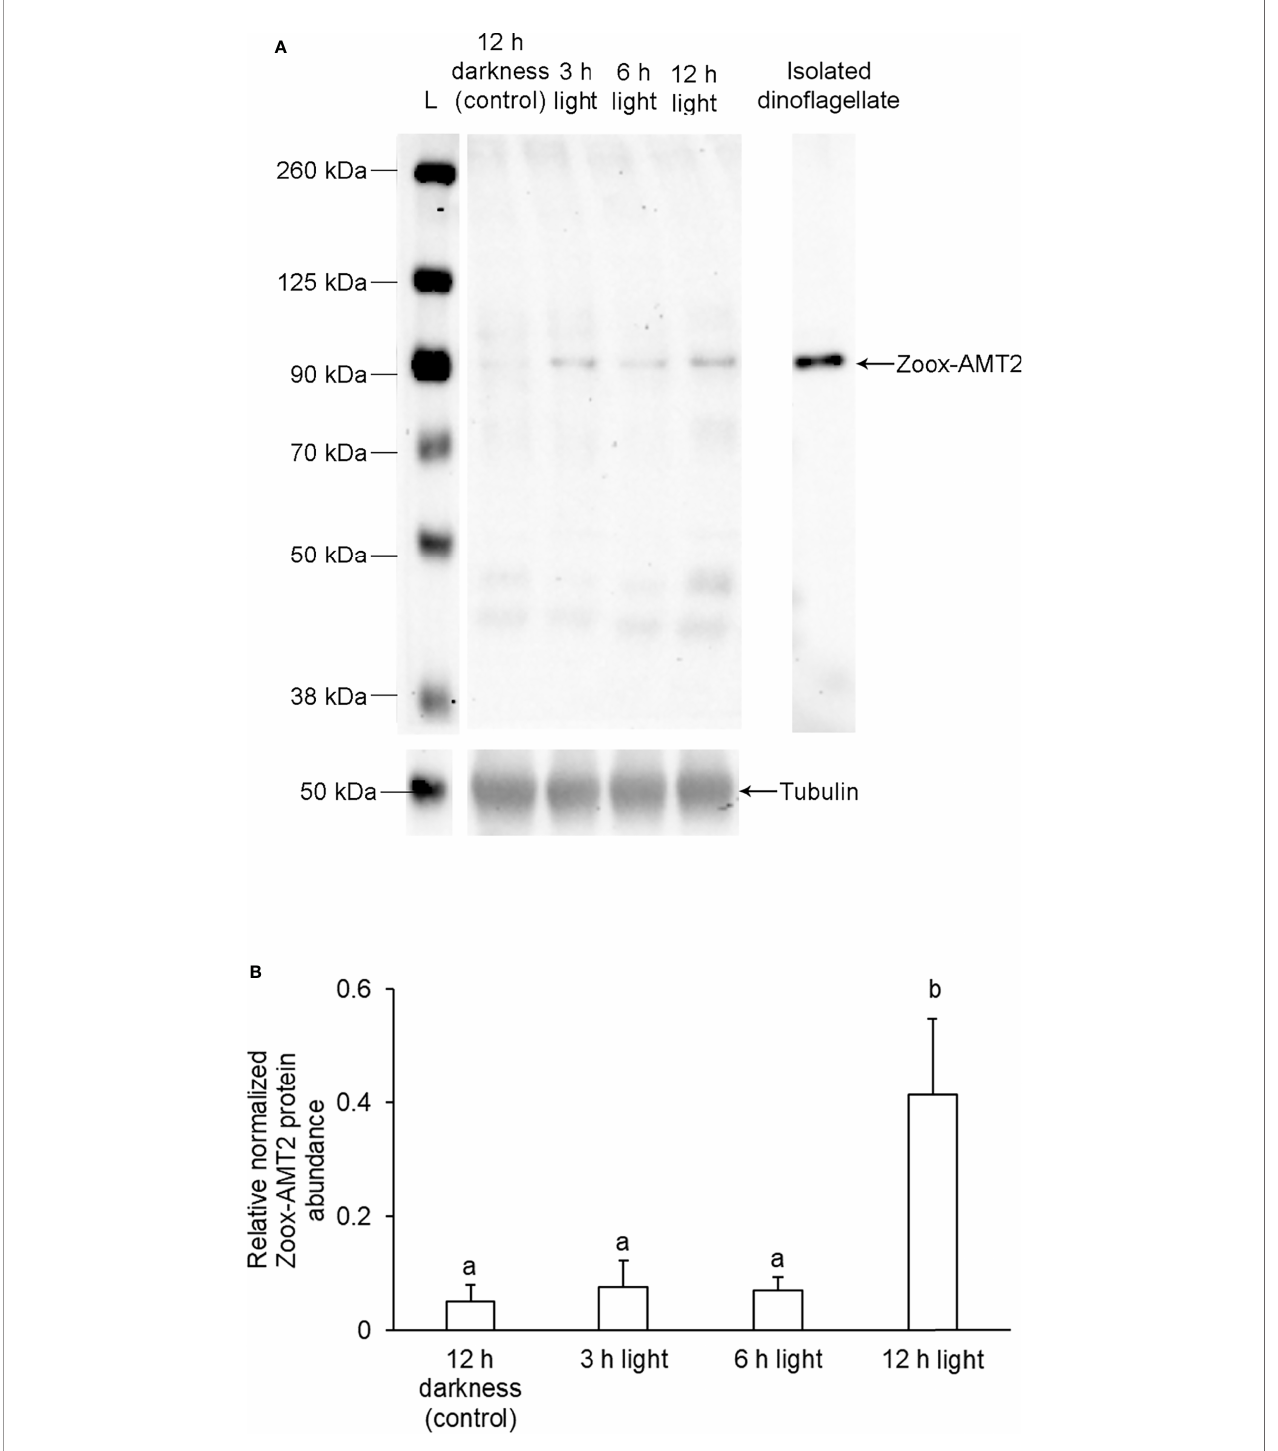
FIGURE 6 | Effects of light exposure on the protein abundance of zooxanthellae-ammonium transporter 2 (Zoox-AMT2) in the outer mantle of Tridacna squamosa . (A) A representative immunoblot of Zoox-AMT2 from the outer mantle and dino fl agellates isolated from the outer mantle of T. squamosa . a -tubulin was used as the reference protein for Zoox-AMT2 from the outer mantle. L represents the ladder. (B) The relative protein abundance of Zoox-AMT2, expressed as arbitrary densitometric units (a.u.), from the outer mantle of T. squamosa exposed to 12 h of darkness (control) or 3, 6, or 12 h of light. Results represent means + SEM. (n = 4). Means that are signi fi cantly different from each other are represented by different letters (p-value <